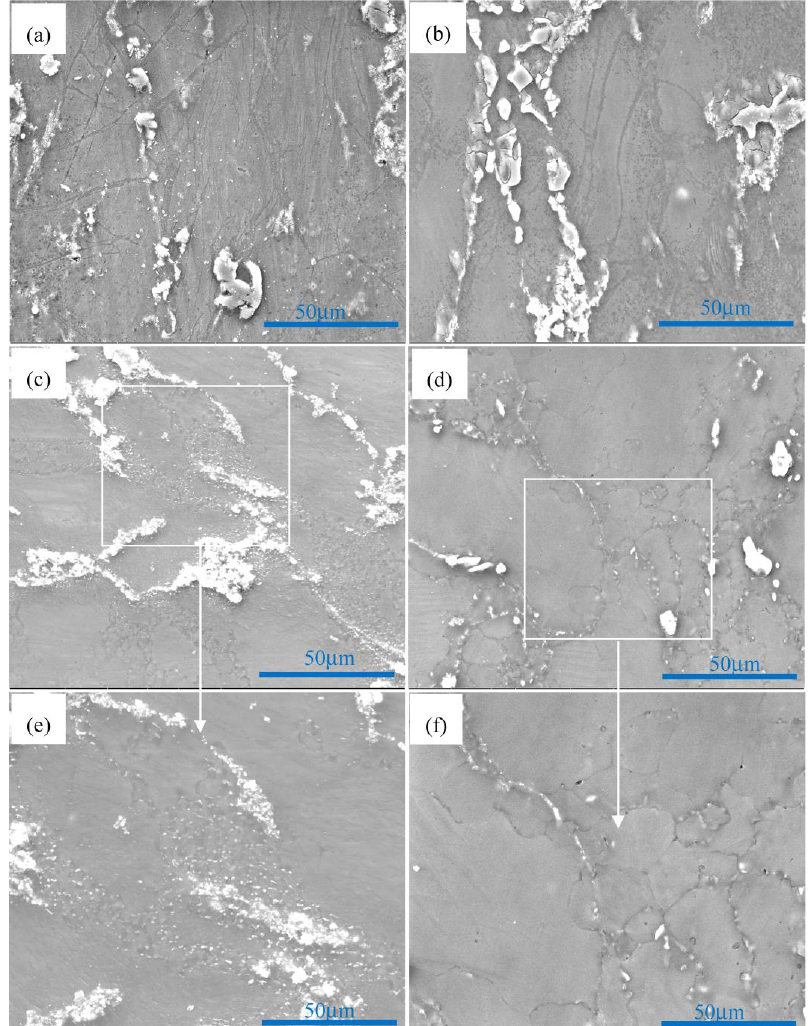
Figure 2. Scanning electron microscopy (SEM) of the nano-SiCp/AZ91 composites after single-pass forging under different temperatures: ( a ) 250 °C; ( b ) 300 °C; ( c , e ) 350 °C; ( d , f ) 400 °C.